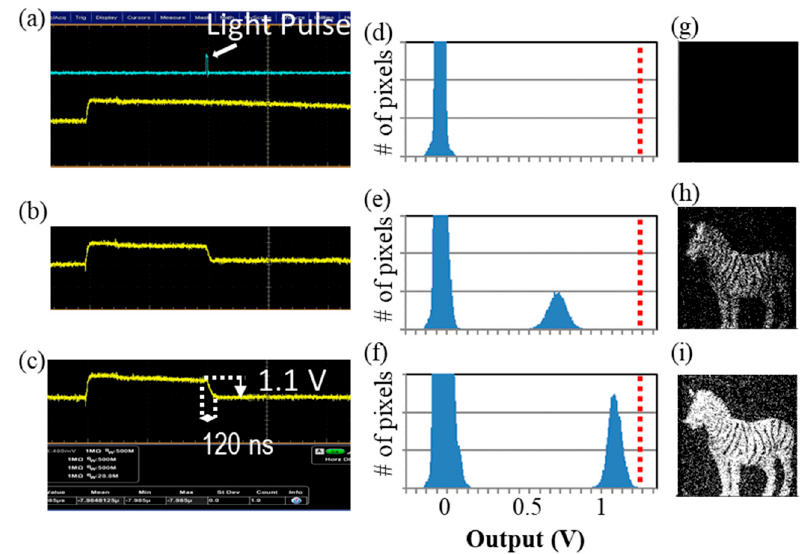
Figure 6. ( a )–( c ) Oscilloscope waveforms of output signals (Yellow: SF output, Blue: Light pulse) of pixels measured at |𝑉 (cid:3032)(cid:3051) | = ( a ) N.A. (non-avalanche region), ( b ) 0.7 V, ( c ) 1.2 V. ( d )–( f ) Histograms of output signal of pixels measured at |𝑉 (cid:3032)(cid:3051) | = ( d ) N.A. (non-avalanche region), ( e ) 0.7 V, (f) 1.2 V. A red line in the graph indicates SF saturation voltage (1.3 V). ( g )–( i ) Pictures of a zebra taken at |𝑉 (cid:3032)(cid:3051) | equals ( g ) N.A. (non-avalanche region), ( h ) 0.7 V, ( i ) 1.2 V. It is noted that the output voltage is slightly less than |𝑉 (cid:3032)(cid:3051) | , e.g., 1.1 V with |𝑉 (cid:3032)(cid:3051) | = 1.2 V. Considering the gain of source follower (0.8), the input referred voltage swing is 1.4 V which is larger than |𝑉 (cid:3032)(cid:3051) | . The measured |Δ𝑉 (cid:3018) | , is plotted in Figure 3 as red circles in comparison to calculated results. The amplitude |Δ𝑉 (cid:3018) | of experiment exceeds |𝑉 (cid:3032)(cid:3051) | and |Δ𝑉 (cid:3018) | = 1.3|𝑉 (cid:3032)(cid:3051) | . The maximum voltage swing is 1.3 V within the measurable range and the designed potential barrier is enough to avoid the overflow.